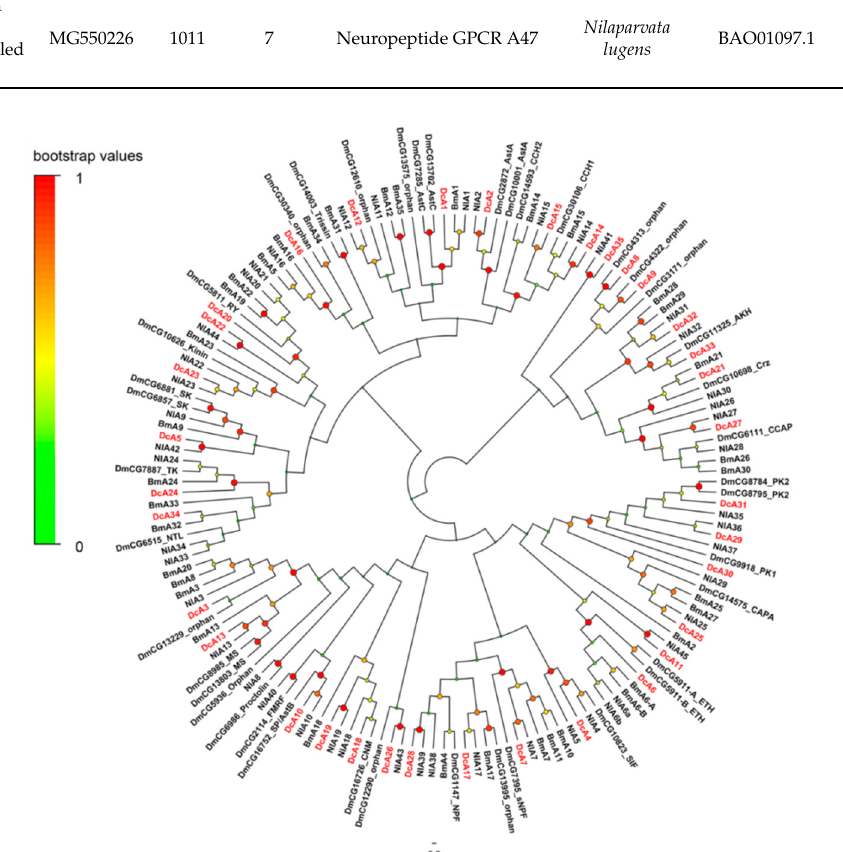
Figure 2. Phylogenetic tree of the A-family neuropeptide GPCRs. The neighbor-joining trees were constructed using MEGA 6 software with 1000-fold bootstrap repetitions. The A-family neuropeptide GPCRs of D. citri are shown in red text. Dc, D. citri ; Dm, D. melanogaster ; Nl, N. lugens .